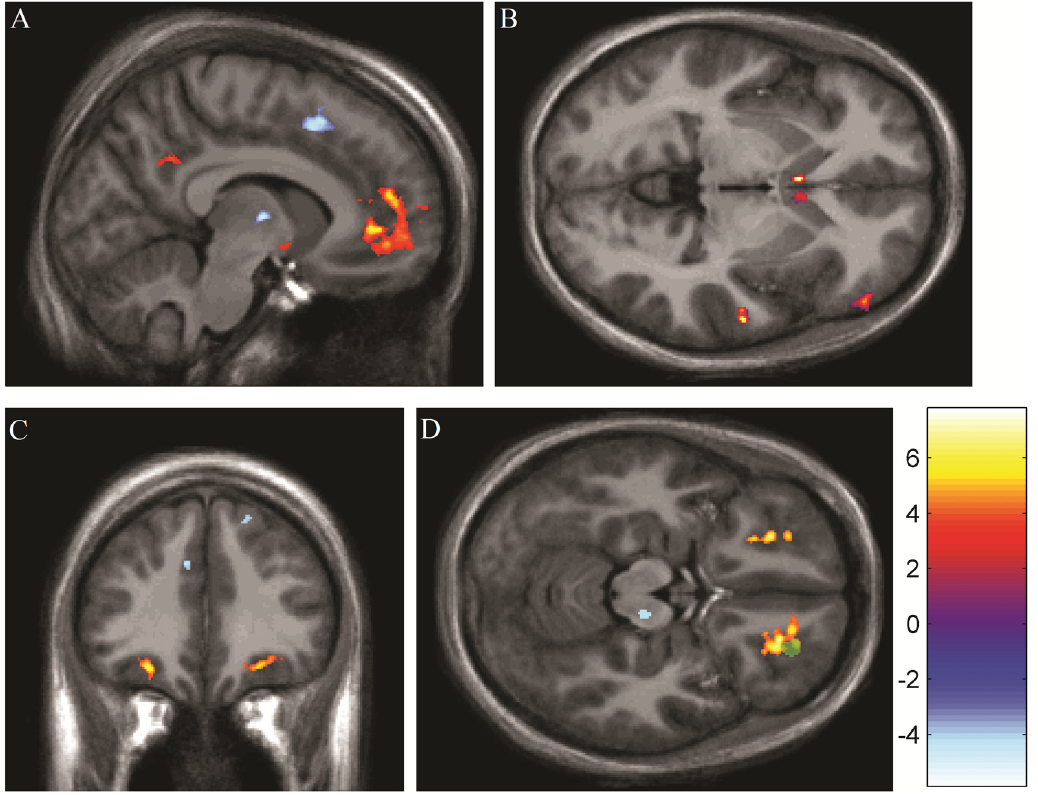
Figure 1. Neural responses associated with viewing pictures of a beloved during periods of acute experimental thermal pain. Significant clusters are shown on an MNI-normalized average of all participants’ high-resolution structural scans. Neurological (right on right) convention is used. (a) Sagittal view (x= 2 8) of conjunction analyses showing areas of BOLD increase (yellow) and decrease (blue) associated with viewing pictures of a romantic partner, over and above both viewing pictures of an attractive and familiar acquaintance, and a word-association distraction task. Activations (anterior to posterior) include the medial orbitofrontal cortex, pregenual anterior cingulate cortex, amygdala, and precuneus. Deactivations are seen in the supplementary motor area and ventral lateral nucleus of the thalamus. (b) Axial view (z= 2 3) of neural activation associated with pain relief during viewing of romantic partner pictures. Greater pain relief was associated with greater activity in the right dorsolateral prefrontal cortex, bilateral caudate head, and right superior temporal gyrus. (c) Coronal view (y=34) of neural activity increase (yellow) and decrease (blue) associated with pain relief during viewing the romantic partner pictures. Pain relief is associated with greater BOLD activity in the bilateral lateral orbitofrontal cortices, and decreased BOLD activity in the left dorsal anterior cingulate cortex and right supplementary motor area. (d) Axial view (z= 2 16) of neural activity increase (yellow) and decrease (blue) associated with pain relief during viewing the romantic partner pictures. Pain relief is associated with greater BOLD activity in the bilateral lateral orbitofrontal cortices, and decreased activity in the right brainstem, approximately in the location of the substantia nigra. Also shown (in green) is an overlapping area of the right lateral orbitofrontal cortex that was also positively associated with analgesia in the distraction